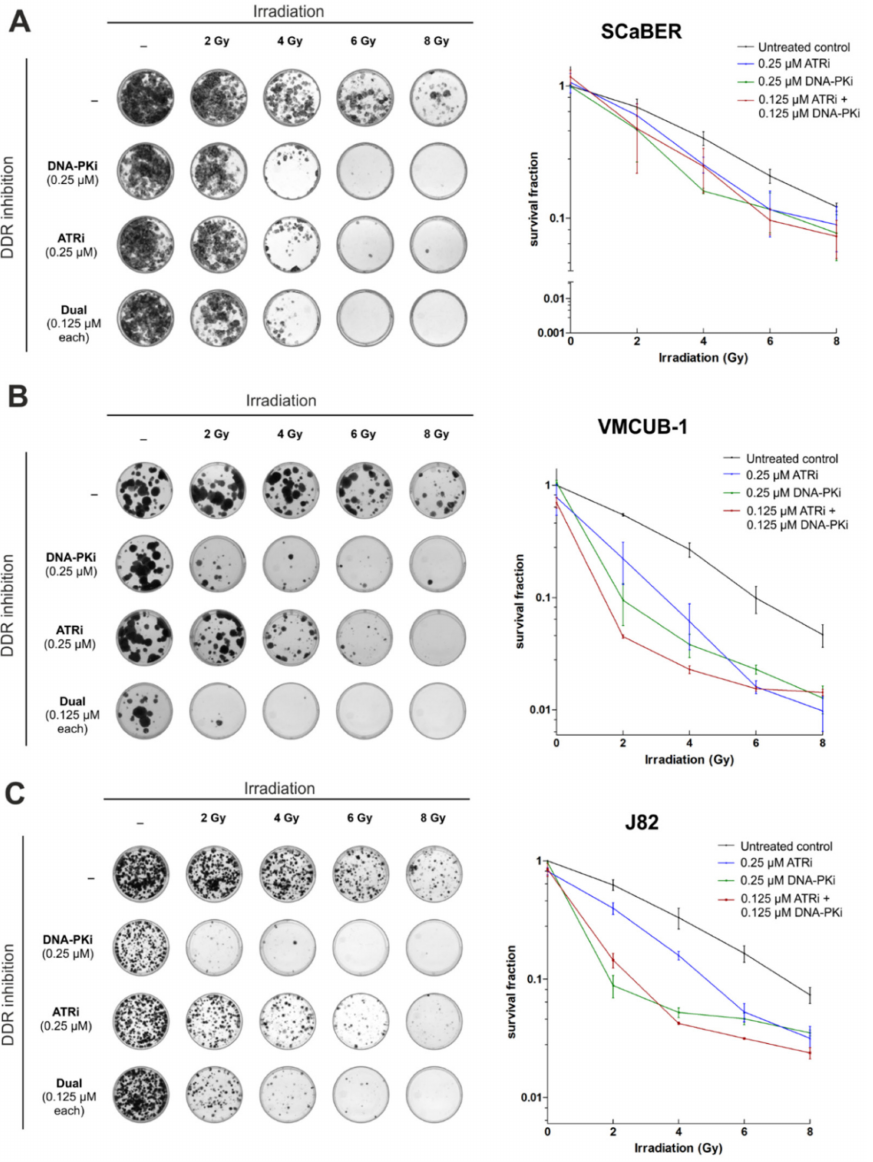
Figure 4. Long-term observation shows a clear inhibition of clonogenic survival of bladder cancer cells after radiation exposure. A clonogenic survival assay was performed to reveal colony formation upon pharmacological single and dual DNA-PK and ATR inhibition with irradiation (2–8 Gy) using SCaBER, VMCUB-1 and J82 bladder cancer cells. Colony growth was assessed for SCaBER ( A ), VMCUB-1 ( B ) and J82 cells ( C ) 14 days after AZD7648 and Ceralasertib treatment in combination with different radiation doses as indicated. DMSO served as the negative control. Left side: Representative images of grown colonies are shown. Right side: Survival fractions (clonogenic potential) are densitometrically illustrated for each cell line. Colony survival curves represent means from at least n = 2 independent